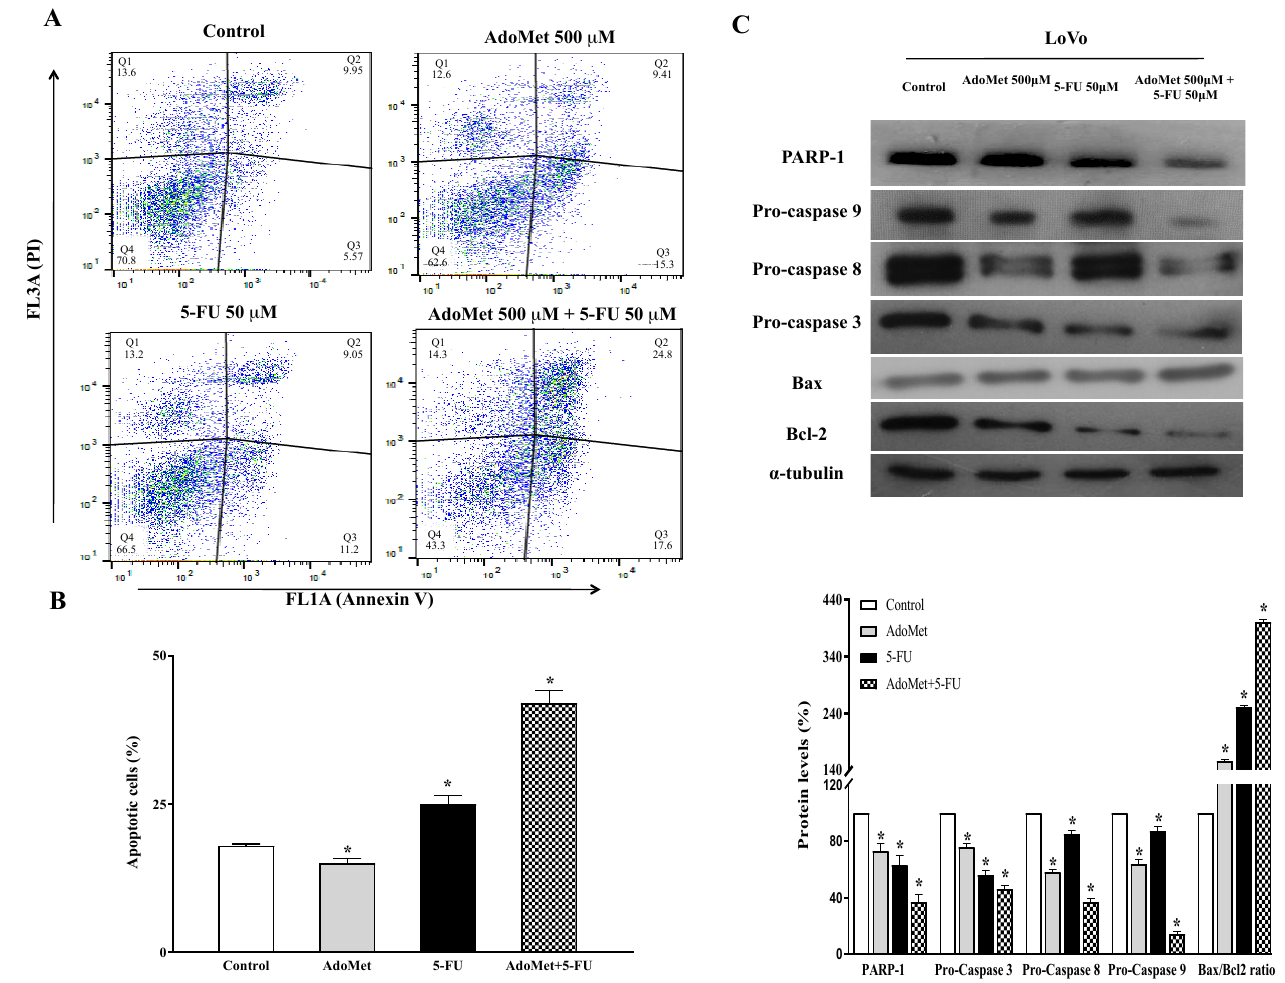
Figure 3. Effect of AdoMet, 5-FU and their combination on apoptosis in LoVo cells. ( A ) Cells were untreated with 5-FU 50 µ M for 24 h with and without 48 h pretreatment with 500 µ M AdoMet. Apoptosis was then evaluated by FACS analysis. Representative dot plots of both Annexin V-FITC and PI-stained cells. The different quadrants report the percentage of cells: viable cells, lower left (Q4); early apoptotic cells, bottom right (Q3); late apoptotic cells, top right (Q2); nonviable necrotic cells, upper left (Q1). For each sample, 2 × 10 4 events were acquired. Analysis was carried out by triplicate determination of at least 3 separate experiments. ( B ) The histogram plot shows, for each single treatment, the percentage of apoptotic cells in the Q2 and Q3 quadrants. Data represent the average of three independent experiments. ( C ) The protein levels of PARP-1, pro-caspase 9, pro-caspase 8, pro-caspase 3, Bax, and Bcl-2 were detected by Western blot analysis using the total cell lysates. The house-keeping protein α -tubulin was used as loading control. The graph reports the relative densitometric analyses expressed as percentage of untreated control (100%). Error bars represent the standard deviation. * p < 0.05 versus untreated cells. The images are representative of three immunoblotting analyses obtained from three independent experiments. Full-length blots are shown in Figure